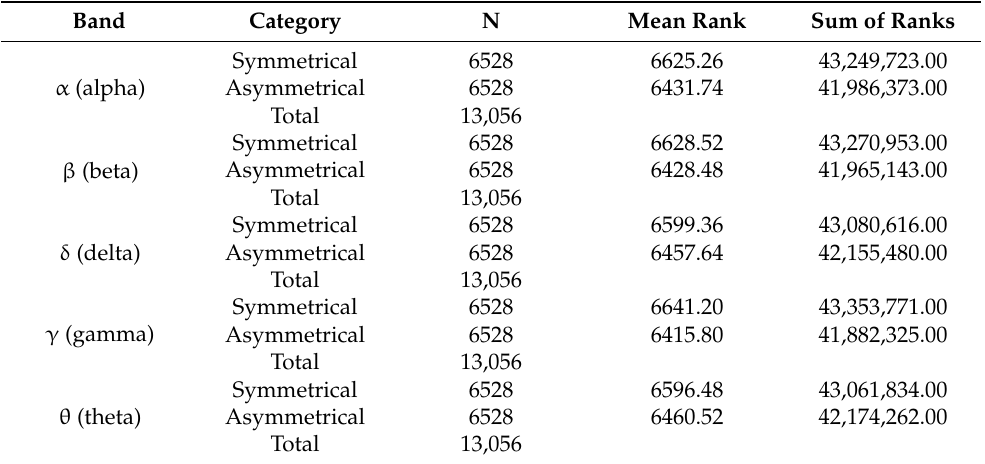
Table A2. Ranks of the mean band measurements related to the Symmetrical and Asymmetrical categories for the Balance VDEP.